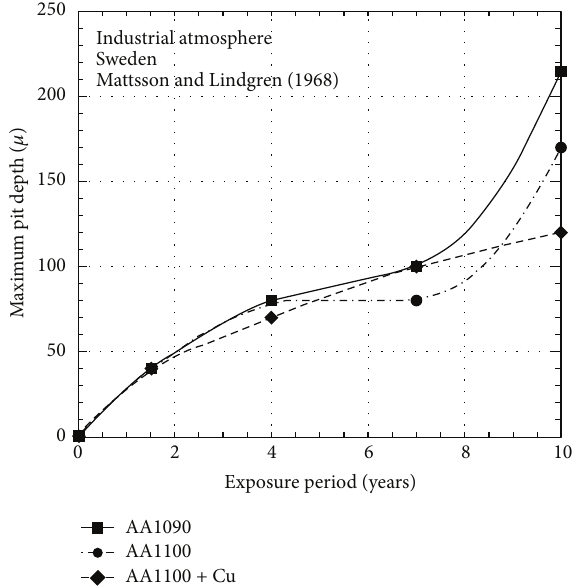
Figure3:DataformaximumpitdepthofaluminiumalloysAA1090, AA1100 alloyed with Cu exposed in an industrial atmospheric environment showing the trends for pit depth are bimodal. The changeover to mode2 occursatabout 7 yearsofexposure. Data from Mattsson and Lindgren